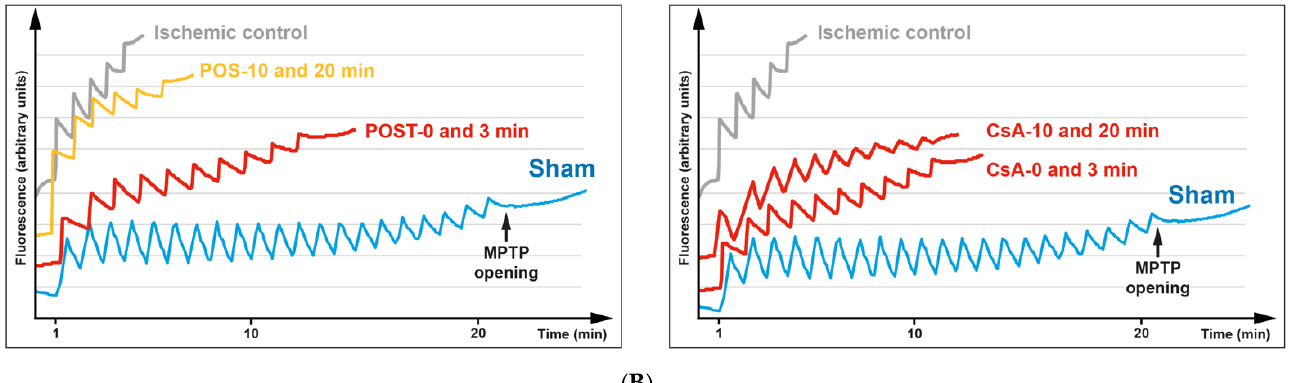
Figure 3. ( A ) Calcium retention capacity (CRC) is used as an indicator of mitochondrial permeability transition pore (MPTP), with the presence of complex II substrates. Delayed protection maintained higher CRC in all CsA groups, while MPTP inhibition was abolished in delayed POST-10 and -20. The insert shows classical plots obtained on sham, ischemic control, and protected hearts. A sche- of CRC measurement. Abbreviations: CsA for cyclosporine A and POST for ischemic postconditioning. N = 6 hearts/group. * p < 0.05 and *** p < 0.001 vs. control. ( B ): Example of dot plot of CRC measurements obtained from each group of hearts. Pulses of 10 nmol of Ca2+ per mg of protein